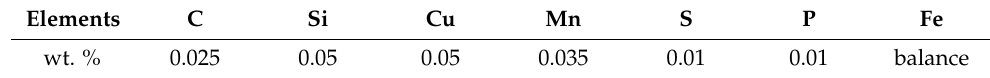
Table 1. Chemical composition of ARMCO iron. Elements C